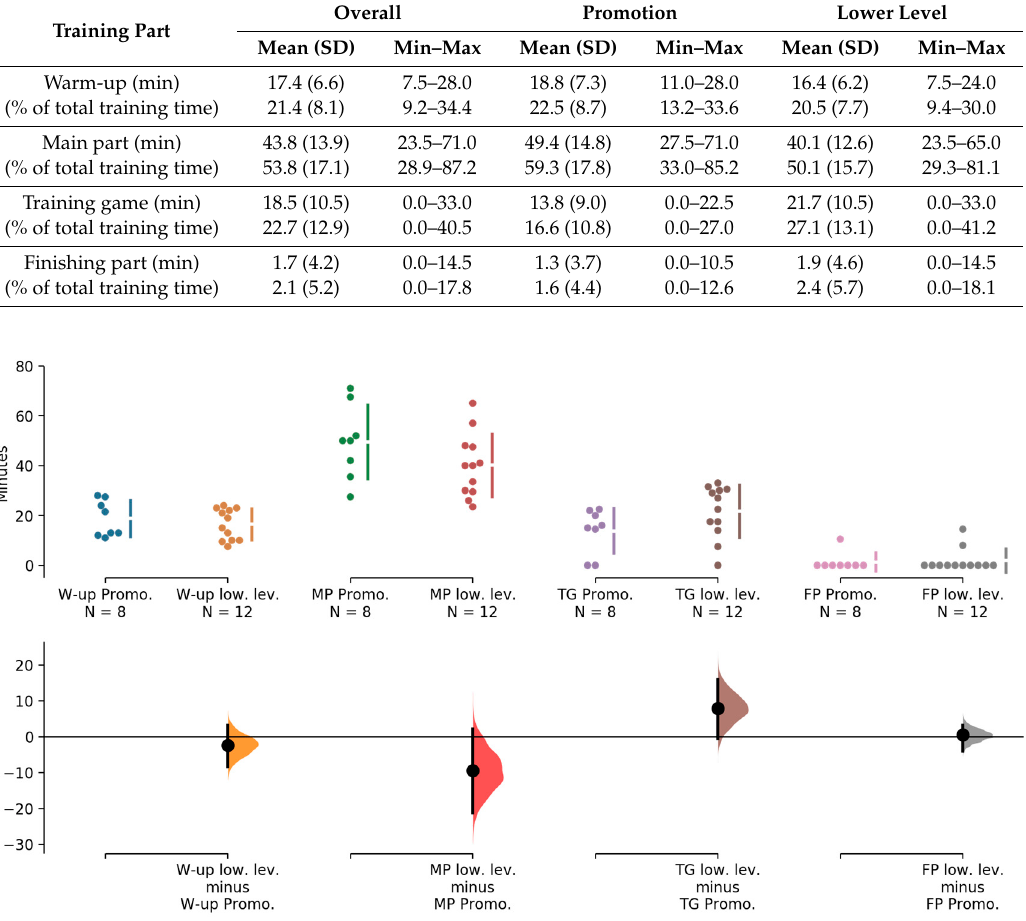
Table 4. Mean heart rates in different training activities during training sessions. Data presented as means with standard deviation and minimum and maximum.